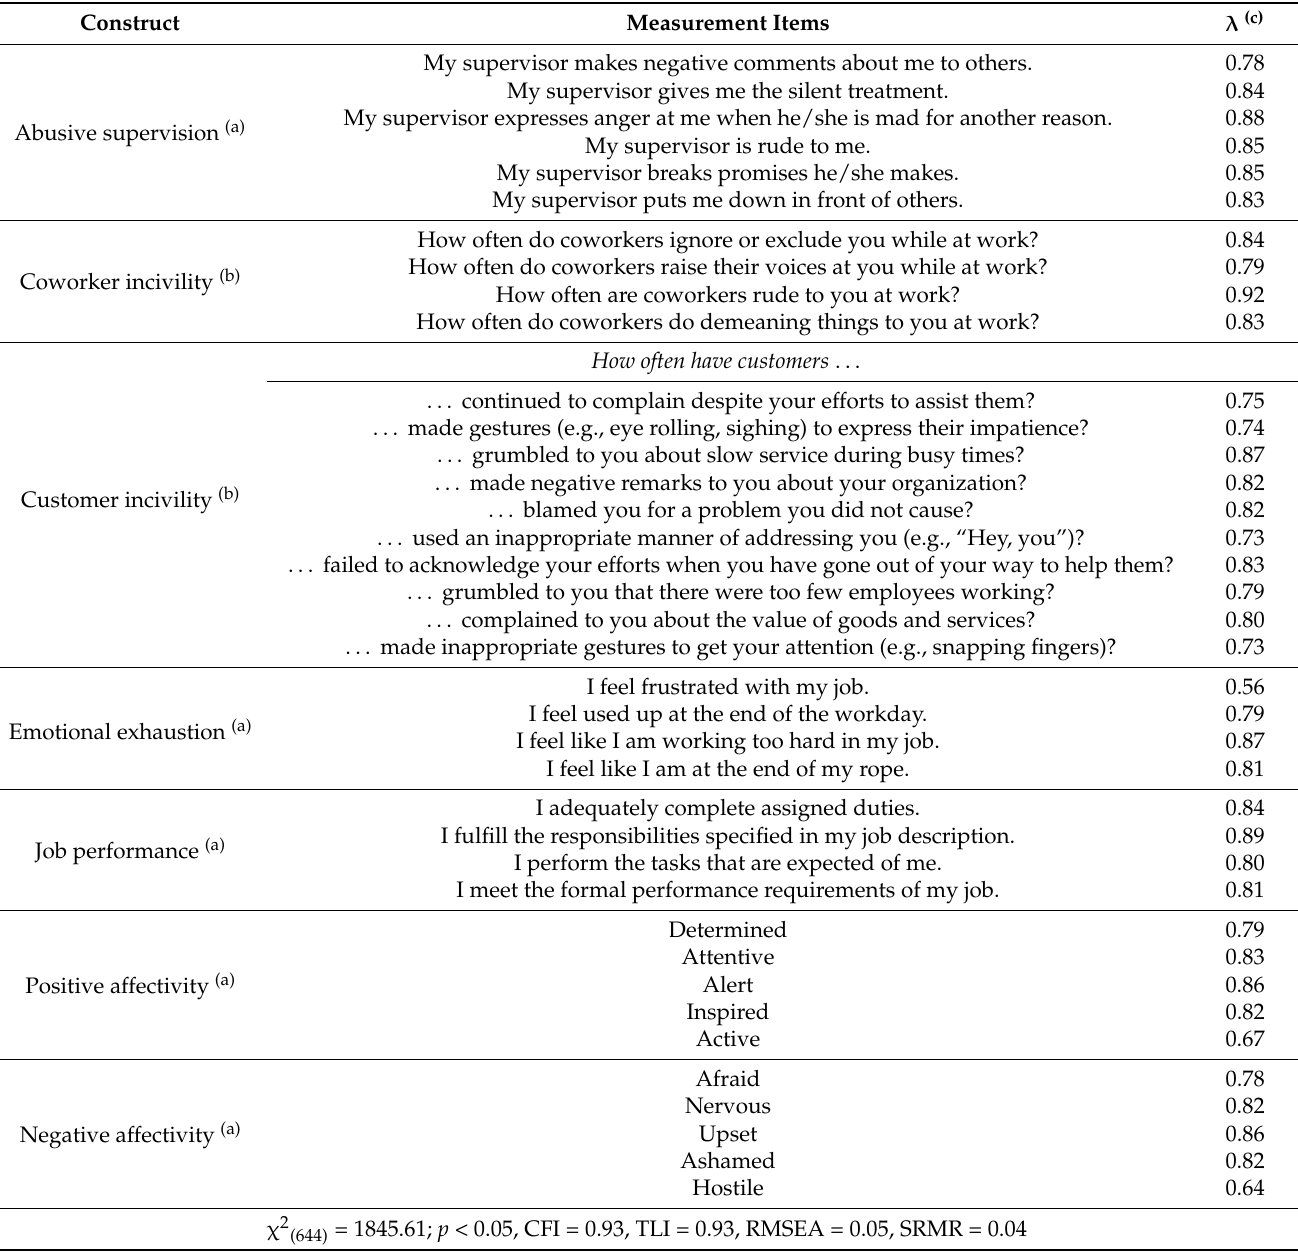
Table 1. Factor analysis results of measurement